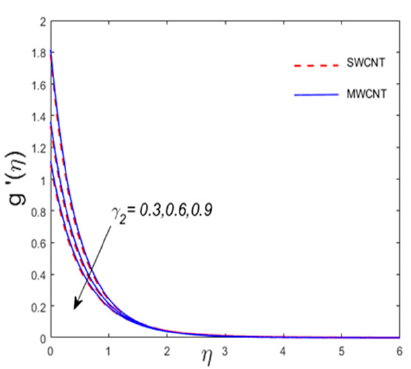
Figure 7. Outcome of γ 1 vs. f (cid:48) ( η ) .